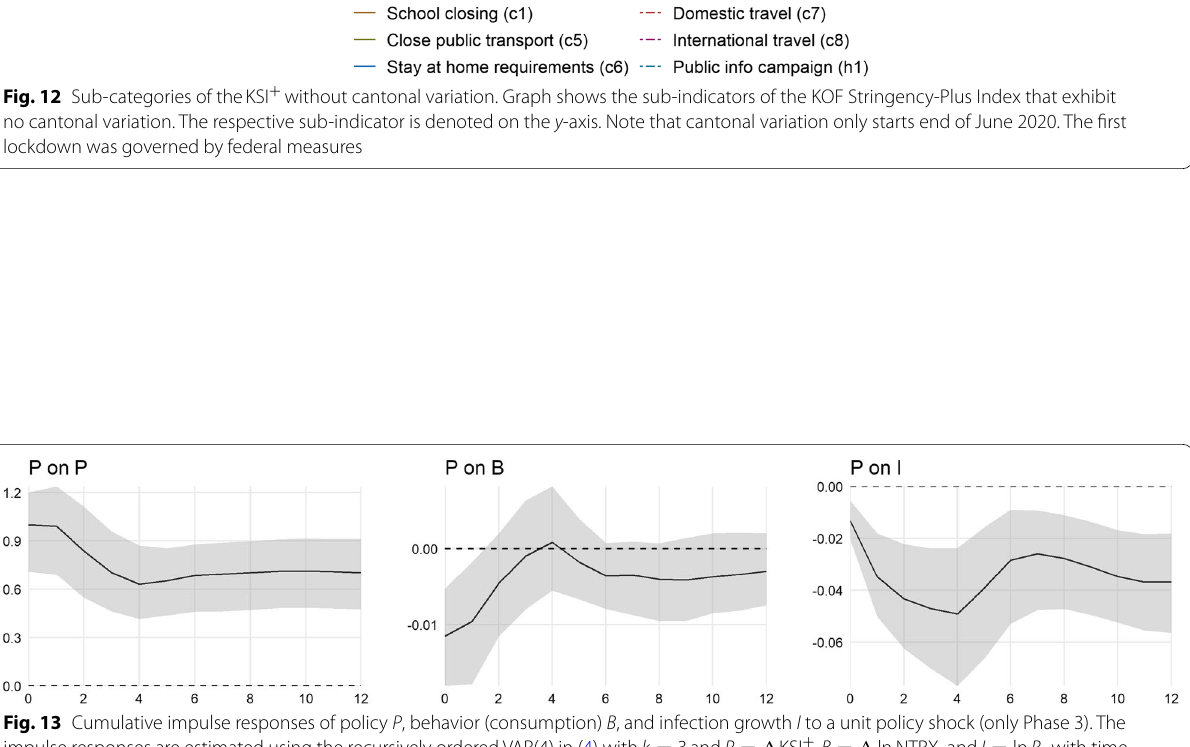
ln R e with time 3 and P (cid:31) KSI + , B (cid:31) lnNTRX , and I = = = =